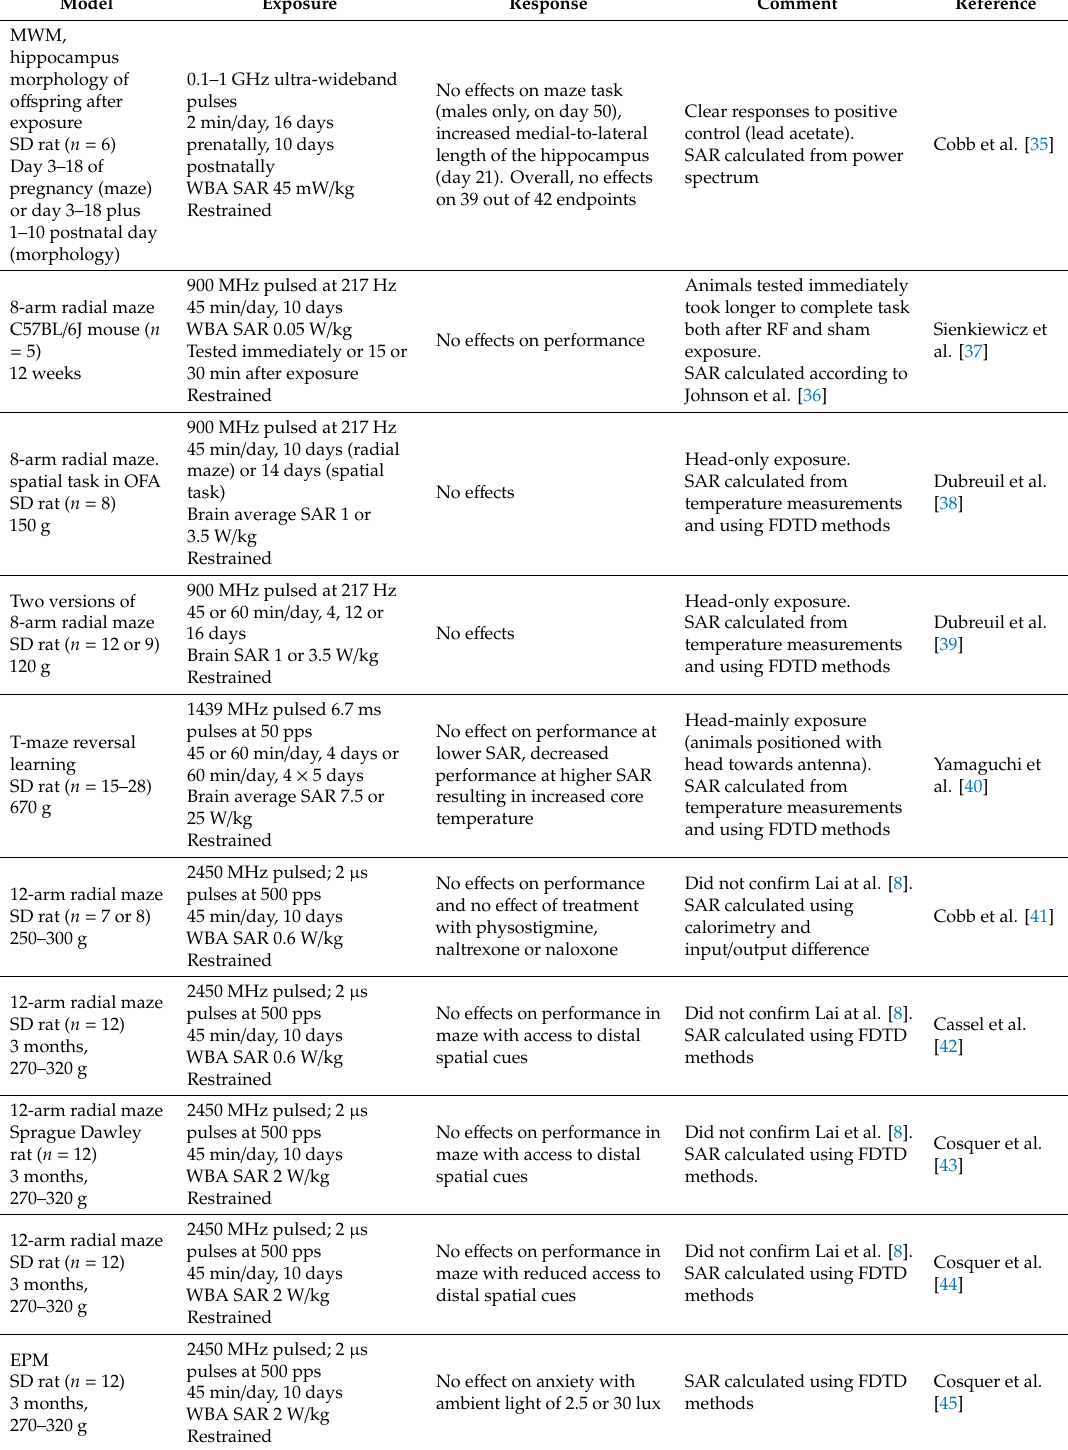
Table 3. Behavioural studies with RF fields reporting an absence of significant e ff ects on place learning and spatial memory. Model